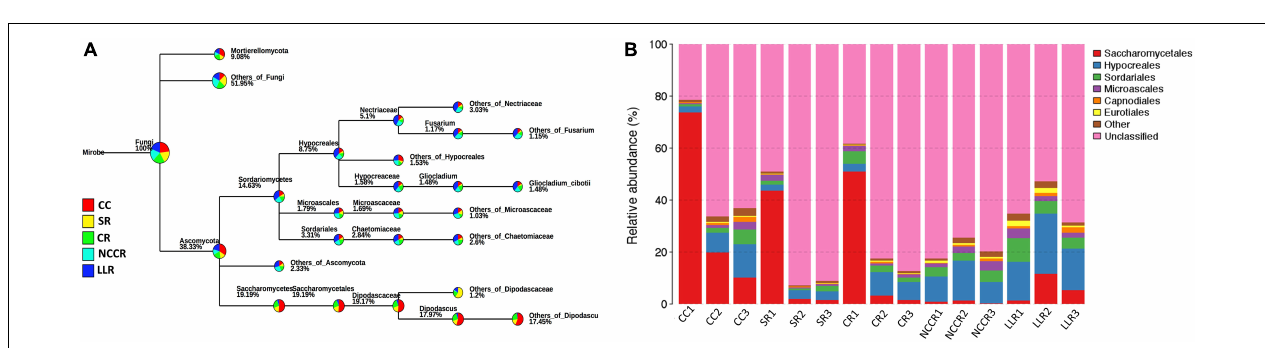
FIGURE 2 | Boxplot and Venn diagram. (A) Boxplots showing alpha diversity (OTUs of observed species, Ace, Chao1 richness estimators, and Shannon diversity index) variation across different treatments. (B) The four-way Venn diagram indicates the OTUs of observed species, and the value in the overlapping circle represents the number of shared OTUs in the treatments.